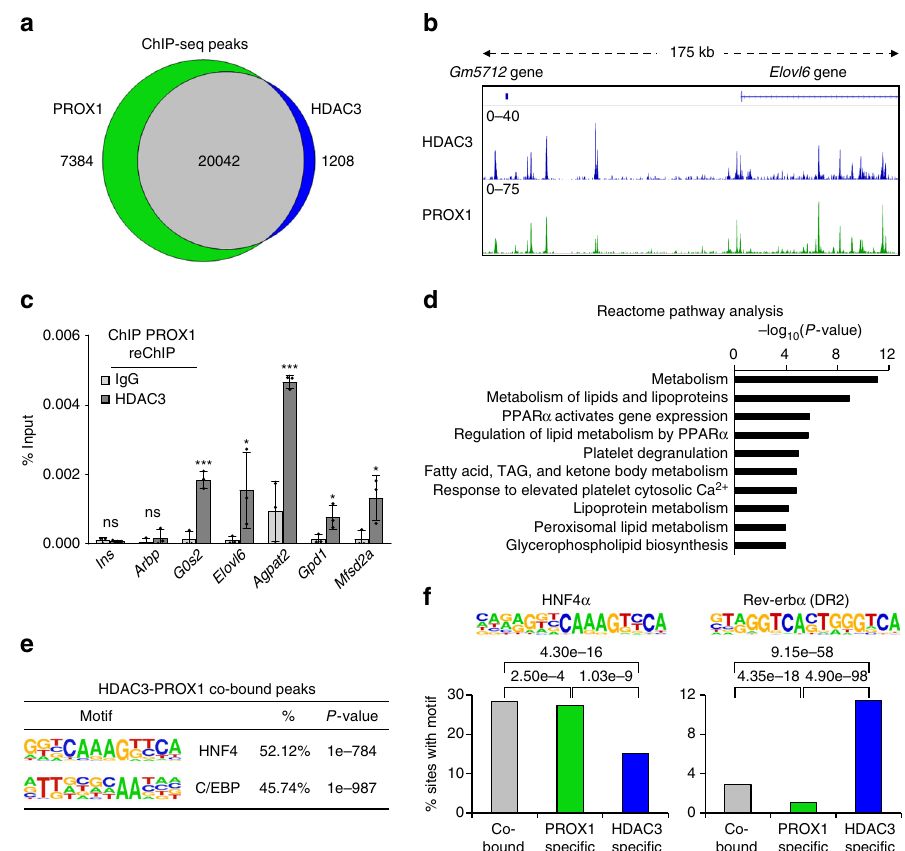
Fig. 2 HDAC3 and PROX1 exhibit extensive co-binding and reveal a metabolic signature. a Venn diagram displaying overlap of peaks identi fi ed in PROX1 (2 rpm cutoff) and HDAC3 (1.5 rpm cutoff) ChIP-seq. Peaks required 50% overlap and have a minimum 1 rpm signal for the other factor. b Representative browser tracks of HDAC3 and PROX1 ChIP-seq. Scale is reads per ten million (RPTM). c Co-occupancy of PROX1 and HDAC3 as indicated by ChIP – reChIP ( n = 3) from liver. Legend indicates reChIP antibody following primary PROX1 ChIP elution. Data are presented as mean ± s.d., one-tailed unpaired Student ’ s t -test, * P < 0.05, ** P < 0.01, *** P < 0.001, ns not signi fi cant. d Reactome analysis of the nearest genes within 100 kb from the top 1000 overlapping HDAC3 and PROX1 peaks. e HOMER motif analysis of co-bound peaks displaying over-represented sequences. f HOMER motif enrichment analysis of the indicated motifs (HNF4 α and Rev-erb α DR2) at overlapping and non-overlapping peaks determined in ( a ). Numbers above brackets indicate P -values, χ 2